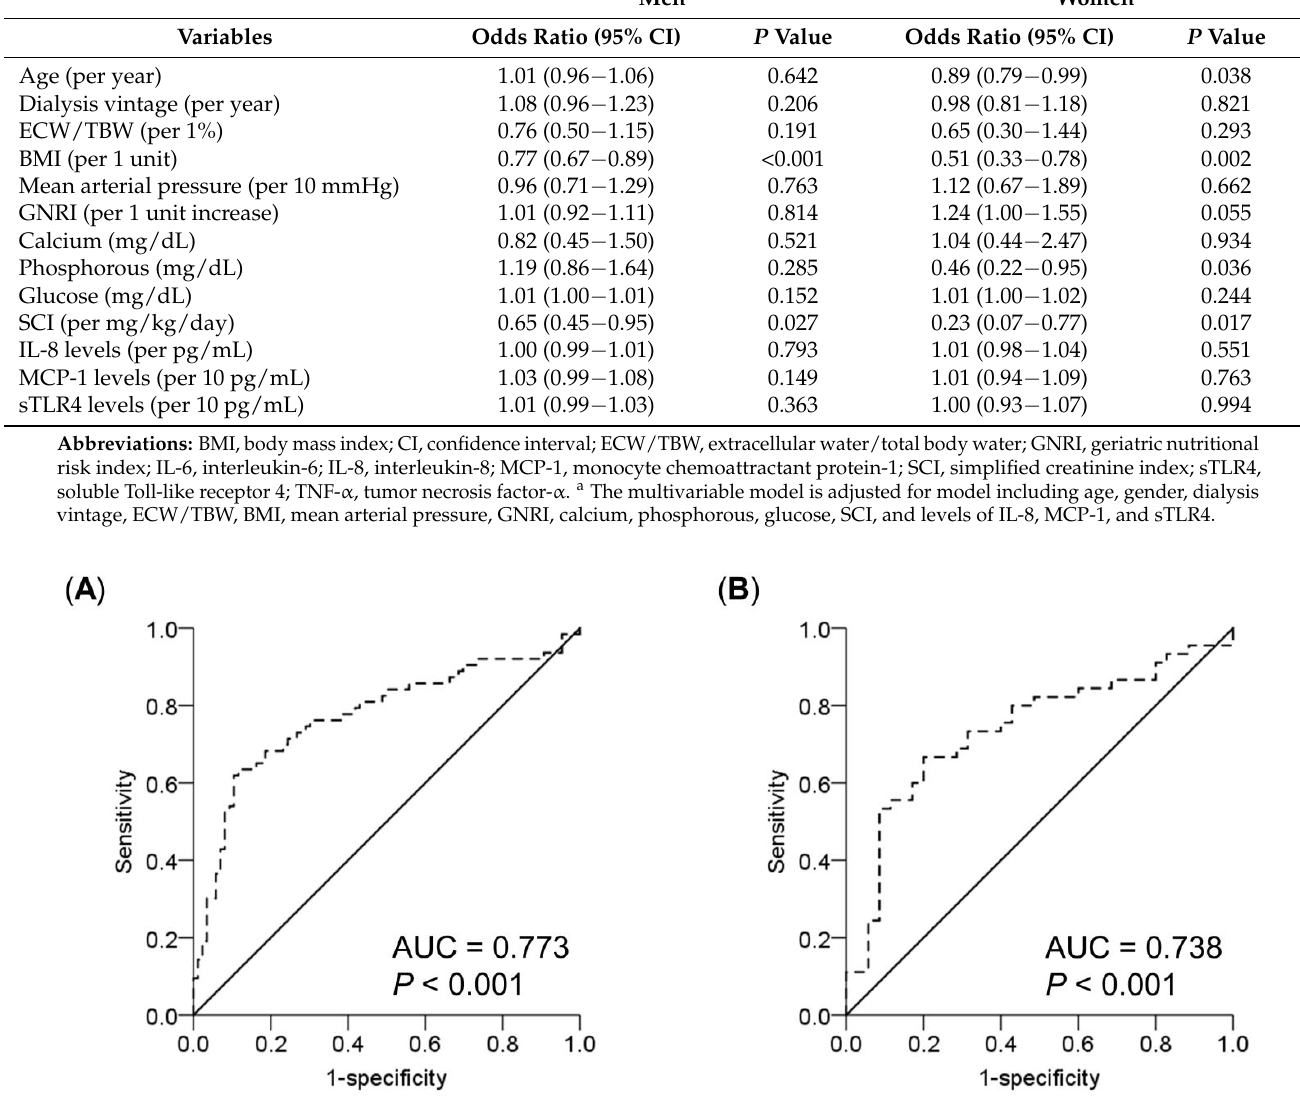
Figure 1. Receiver operating characteristic (ROC) curves of simplified creatinine index for prediction of reduced lean body mass in male ( A ) and female ( B ) hemodialysis patients. The area under the curve (AUC) represents the probability to discriminate a reduction in lean body mass in these subjects.